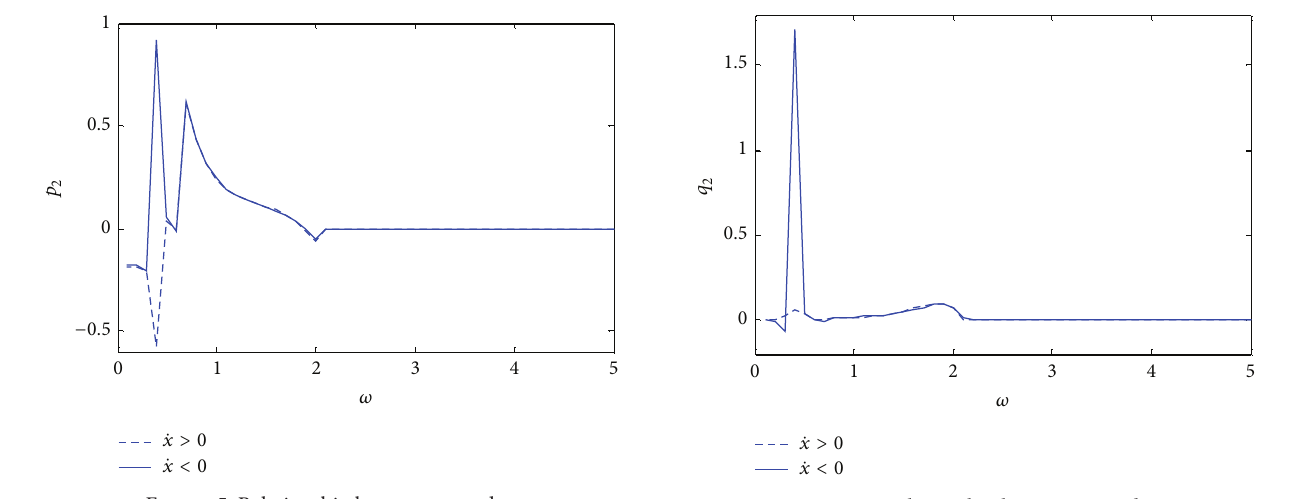
Figure 8: Relationship between 𝑞 2 and 𝜔 .